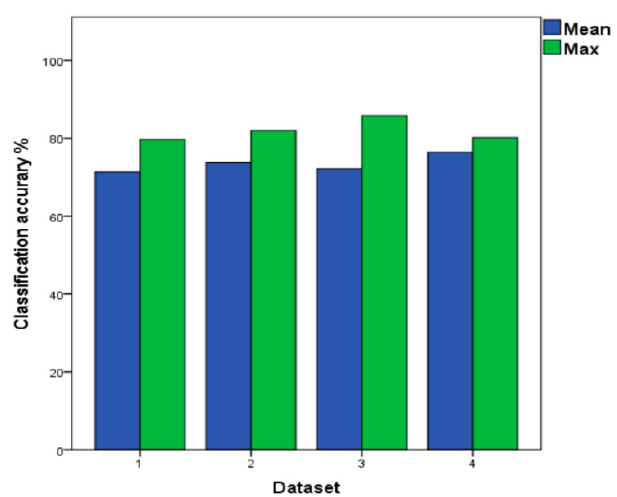
Figure 10. The Mean and Maximum Values of LSTM under the Four Datasets.